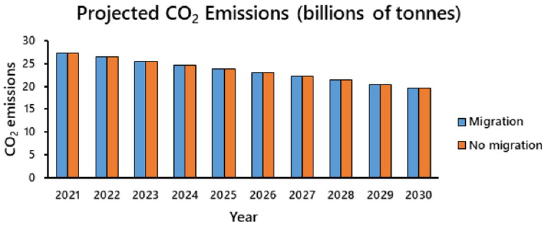
Fig 3. Projected CO 2 emissions attributable to global human migration from 2021 to 2030 (assumes growth only through migration and that all nations achieve a 30% reduction relative to 2005 levels; N = 175; values calculated with data obtained from https://ourworldindata.org; downloaded 15 December